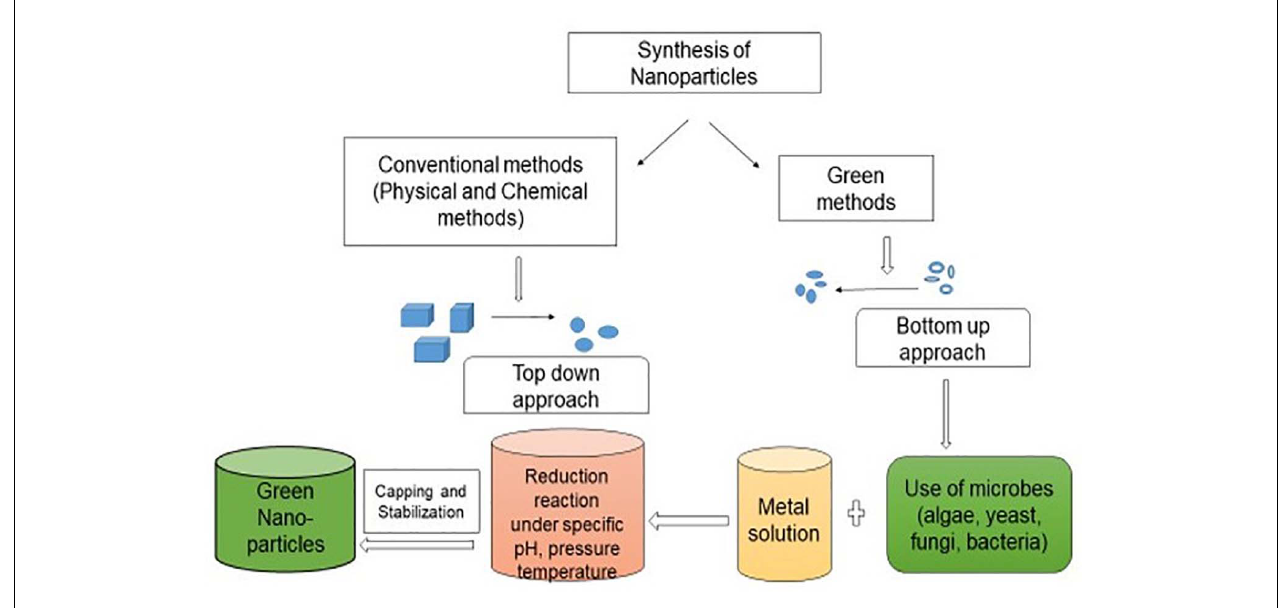
FIGURE 1 | Synthesis of nanoparticles by different